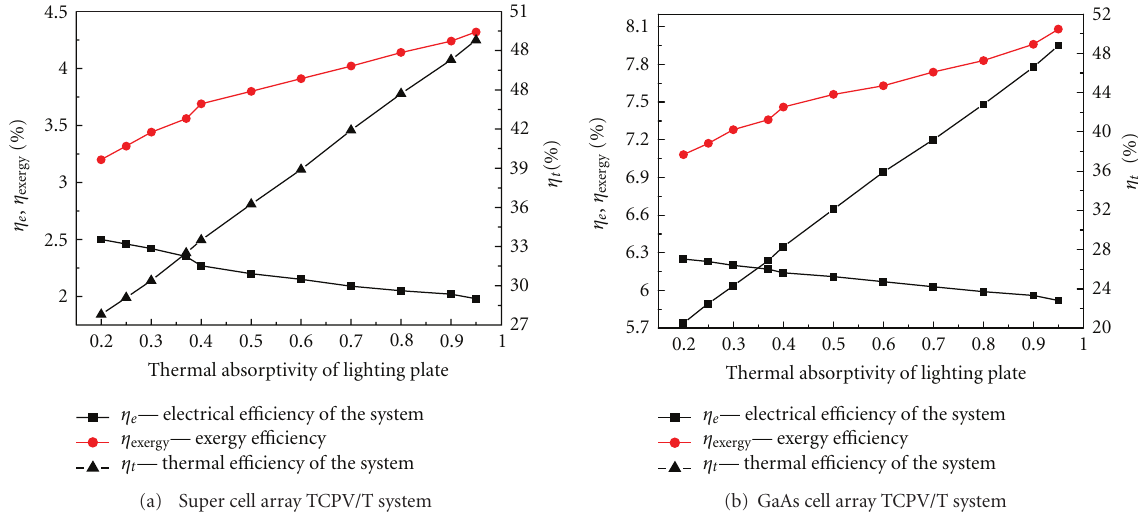
Figure 9: The influences of thermal absorptivity of lighting plate on the system performances.